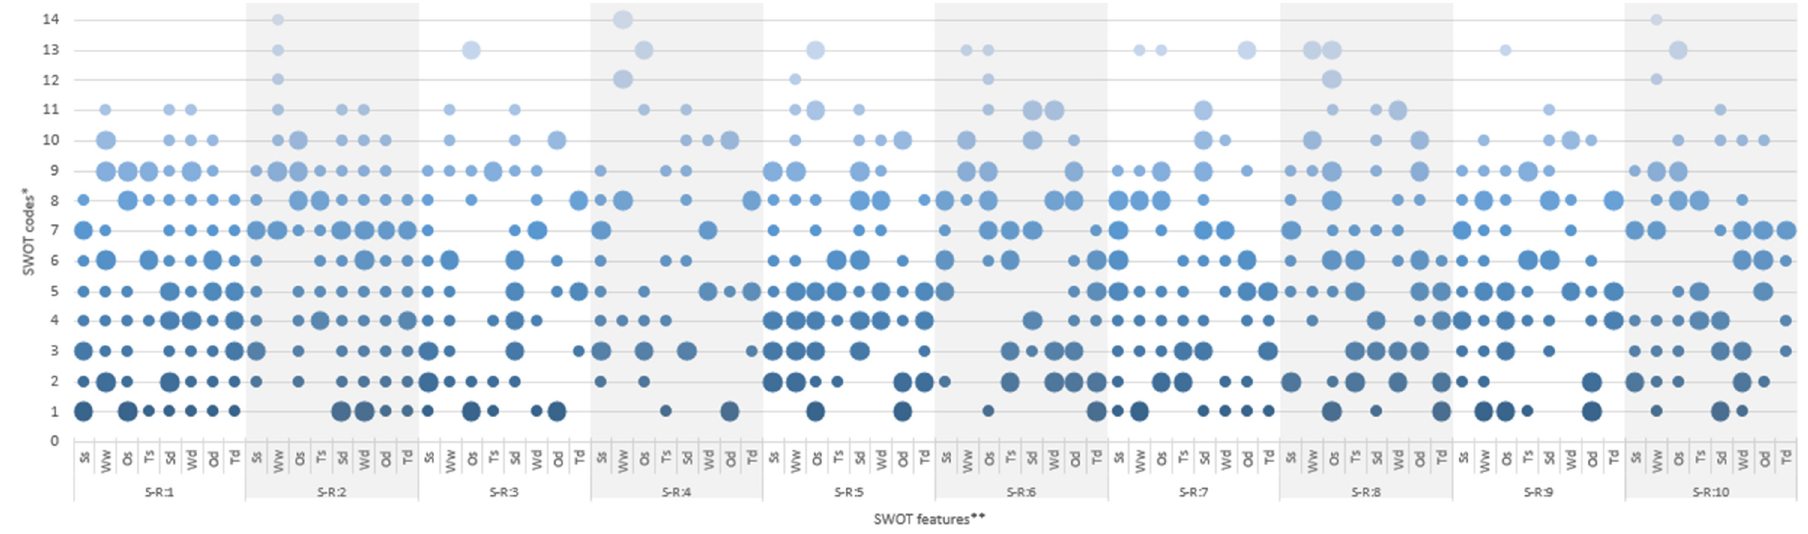
Figure A1. Clustered SWOT elements to formulate short run BSChs features to feed the Delphi questionnaire (larger circles represent the main elements while the smaller circles represent supporting elements)1. * SWOT codes correspond to the numbering of SWOT elements in Tables A1–A4, i.e., Ss-1 Inferior good at the heat market ** SWOT features correspond to the numbering of short run: immediate action BSCh features in Table 3; i.e., S-R:1. Increase in pellet production due to improved forest management.